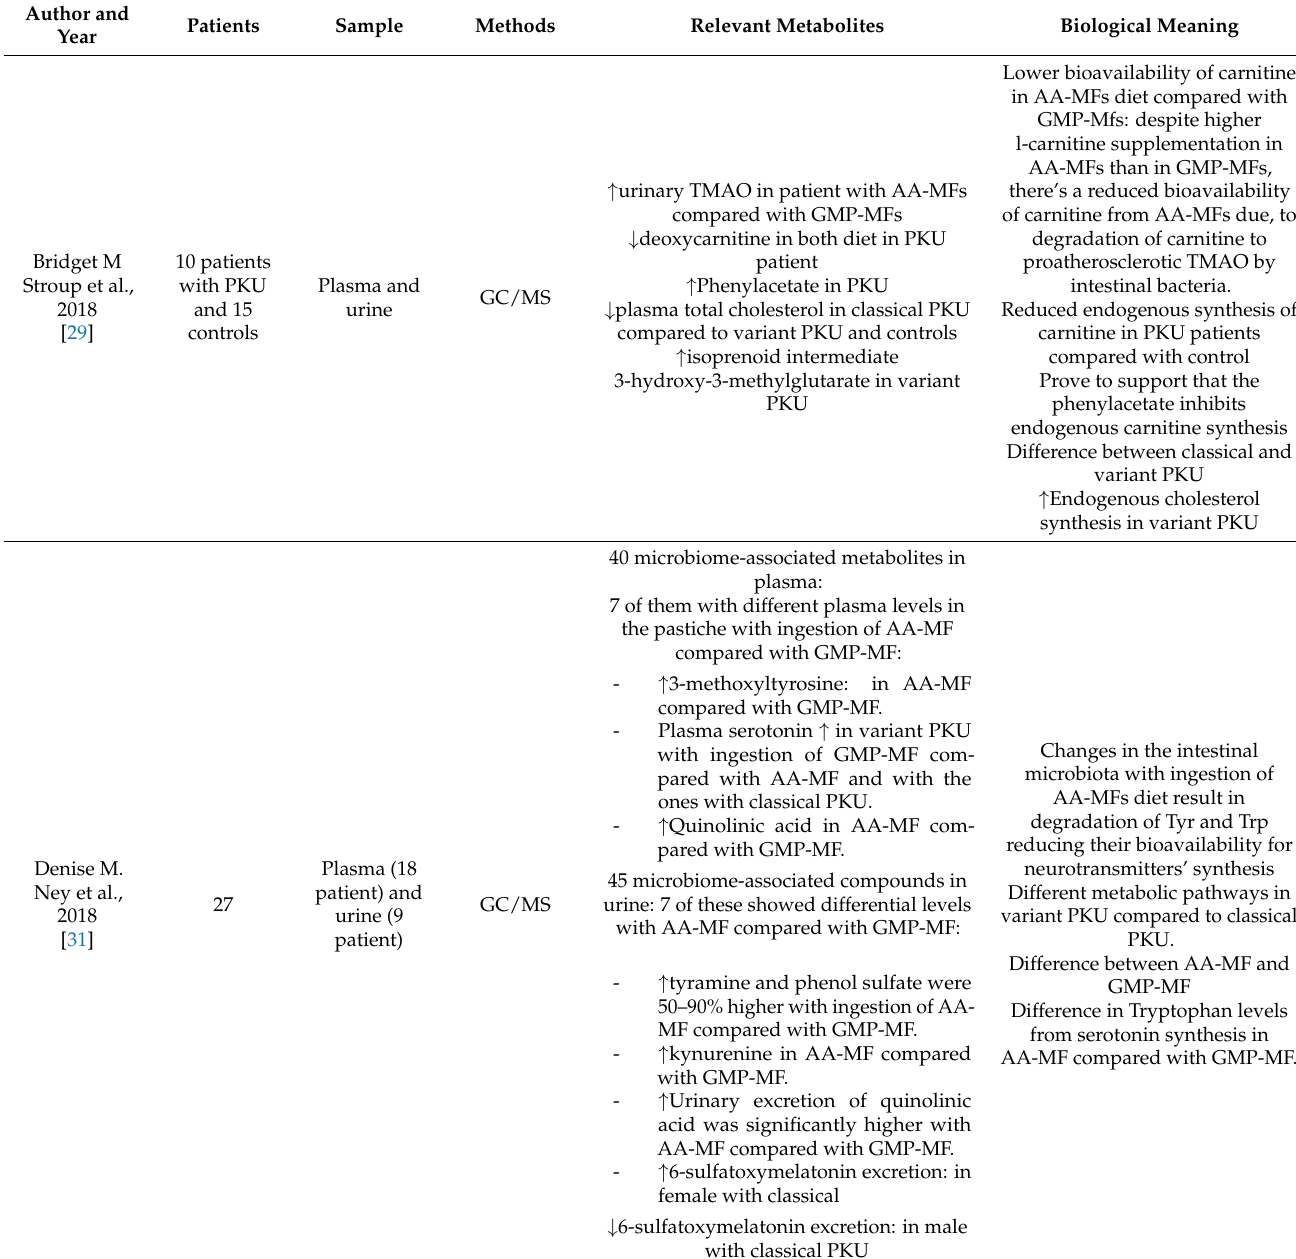
Table 3. Relevant metabolomics studies applied to different nutritional regimens in